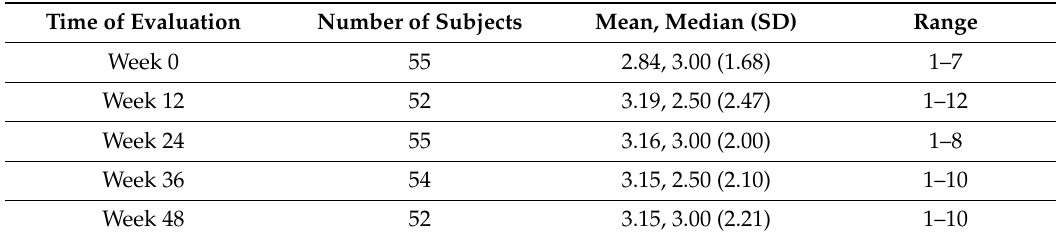
Table 1. Summary of normalized forward digit span over time in subjects.